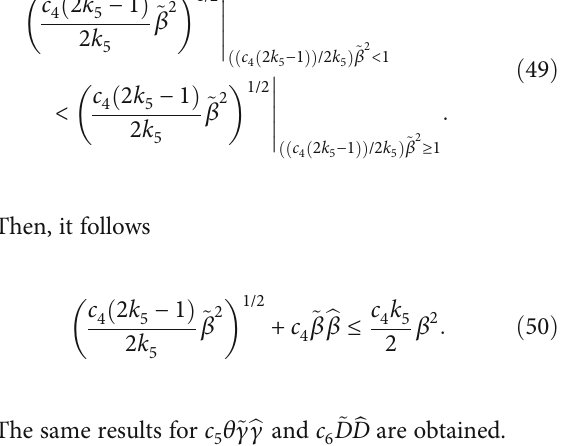
Figure 4: Angular velocity tracking error using the fi nite-time controller.